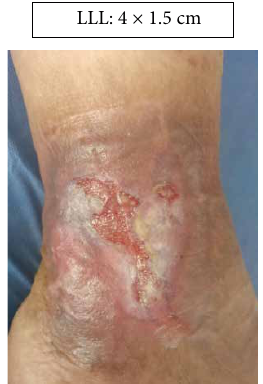
Figure 22: Week 12. Lower left